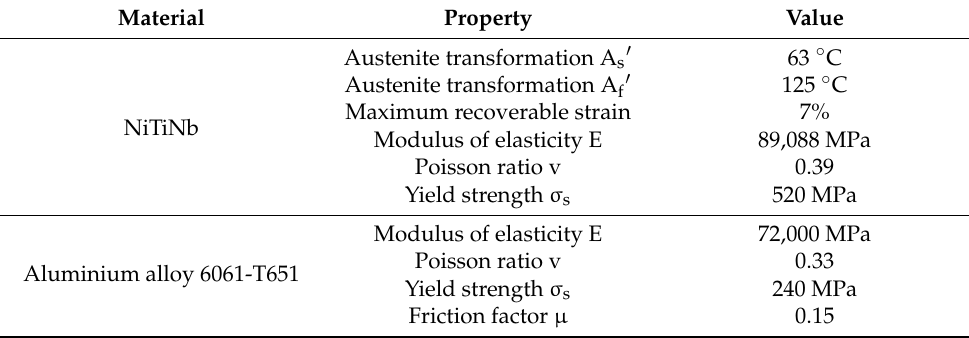
Table 1. Material parameters.